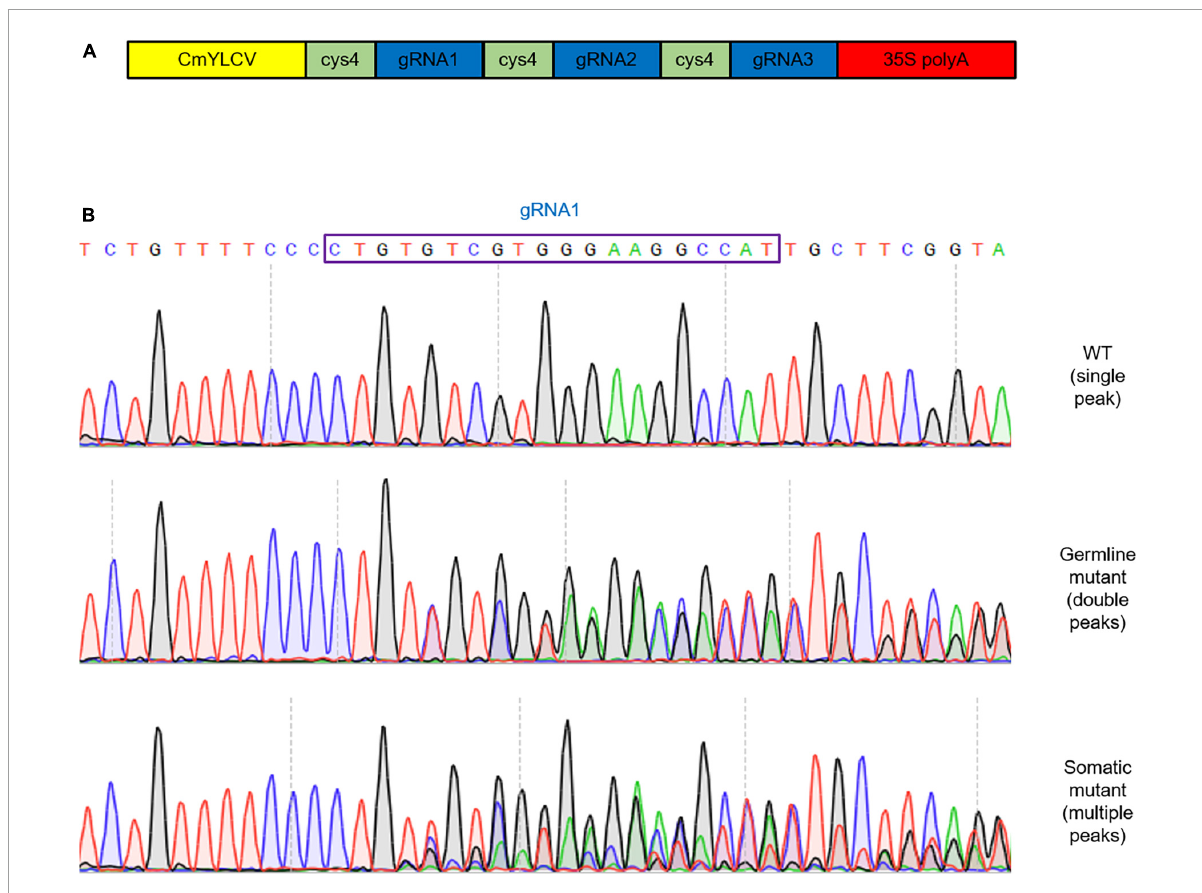
FIGURE3 Germline and somatic mutations detected in T1 transgenic plants. (A) Structure of multi-array gRNA cassette carrying gRNA1, gRNA2, and gRNA3 to target ARP2 , and introduced to GFP-PIN1 expressing plants. The CmYLCV promoter and 35S poly A terminator were used. (B) DNA sequences of variant deletion from Sanger sequencing of PCR products. The sequences and chromatograms of the unmodified locus for gRNA1 in WT (top), germline mutant line (middle), and somatic mutant line (bottom). gRNA1 target site is marked in a blue